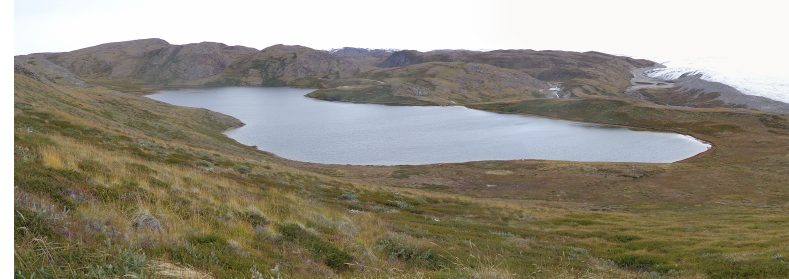
Figure 2. Photo of the Two Boat Lake catchment heading north east. To the right the Greenland ice sheet is